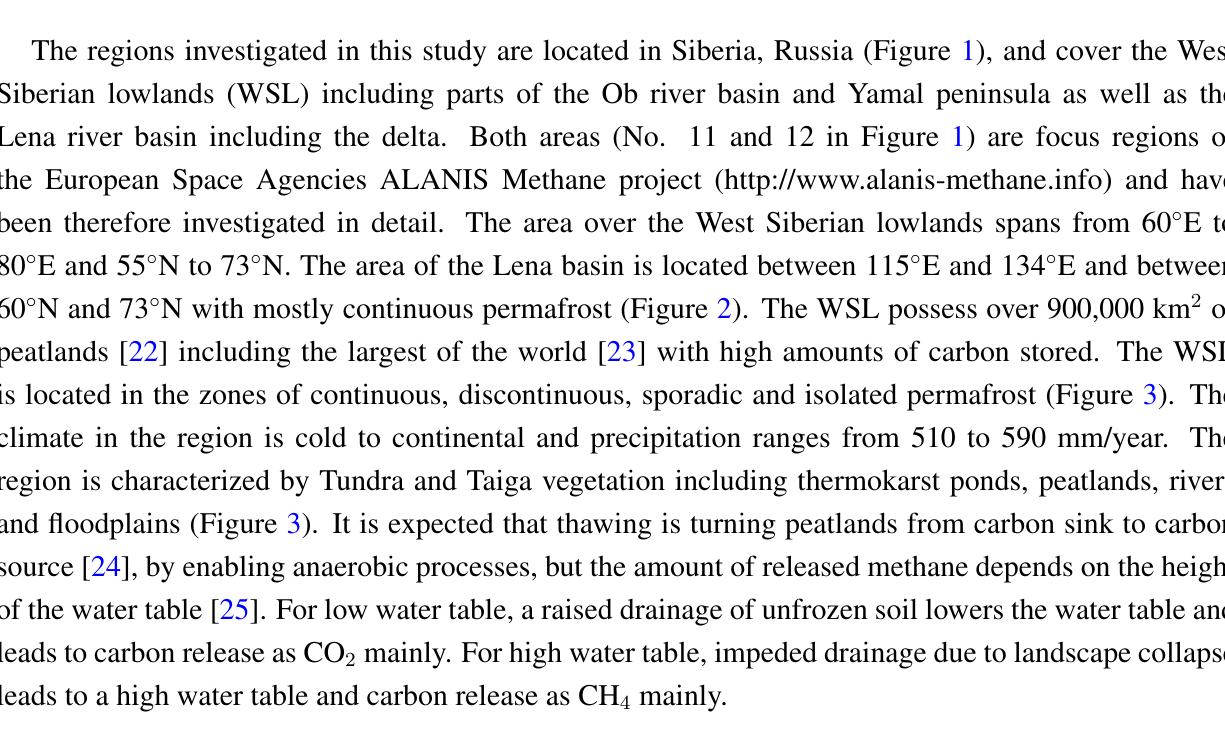
Figure 1. Extent of mosaics processed for the ALANIS Methane dataset, with IDs included (e.g., 11 corresponds to Ob region and 12 to the Lena basin and